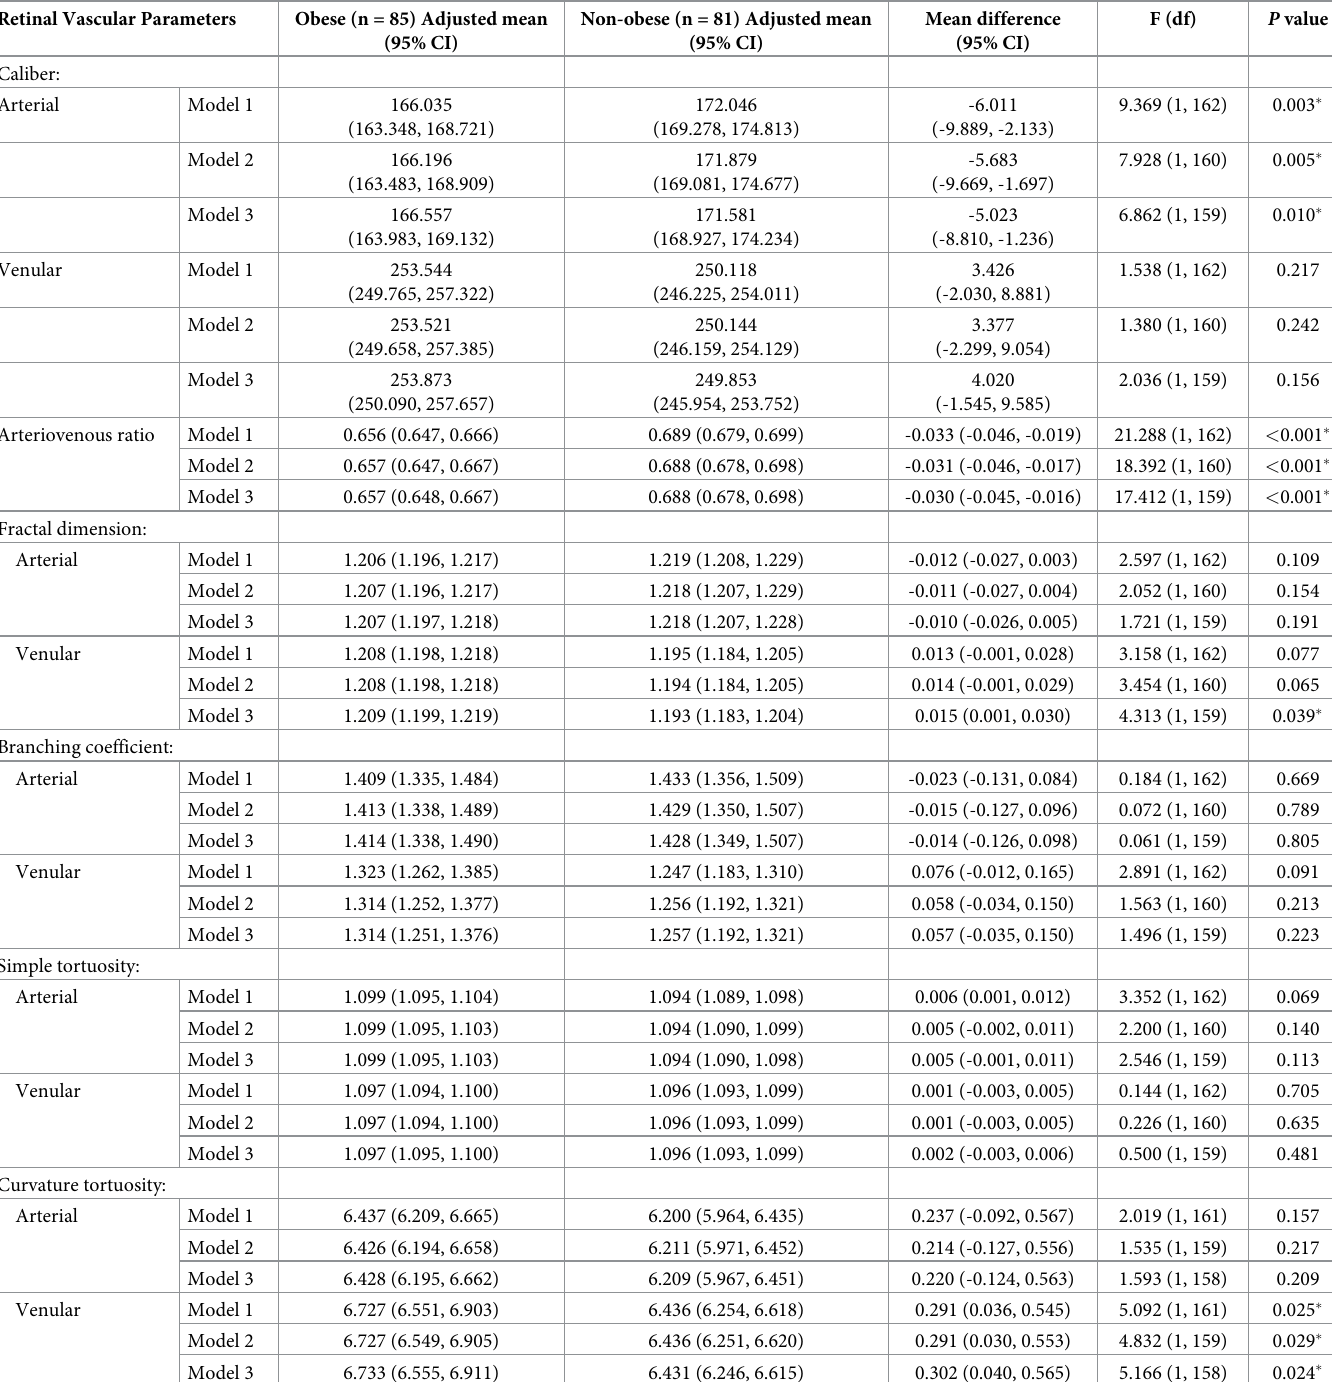
Table 2. Comparison of retinal vascular parameters (caliber, fractal dimension, branching coefficient, tortuosity) between obese and non-obese children. Retinal Vascular